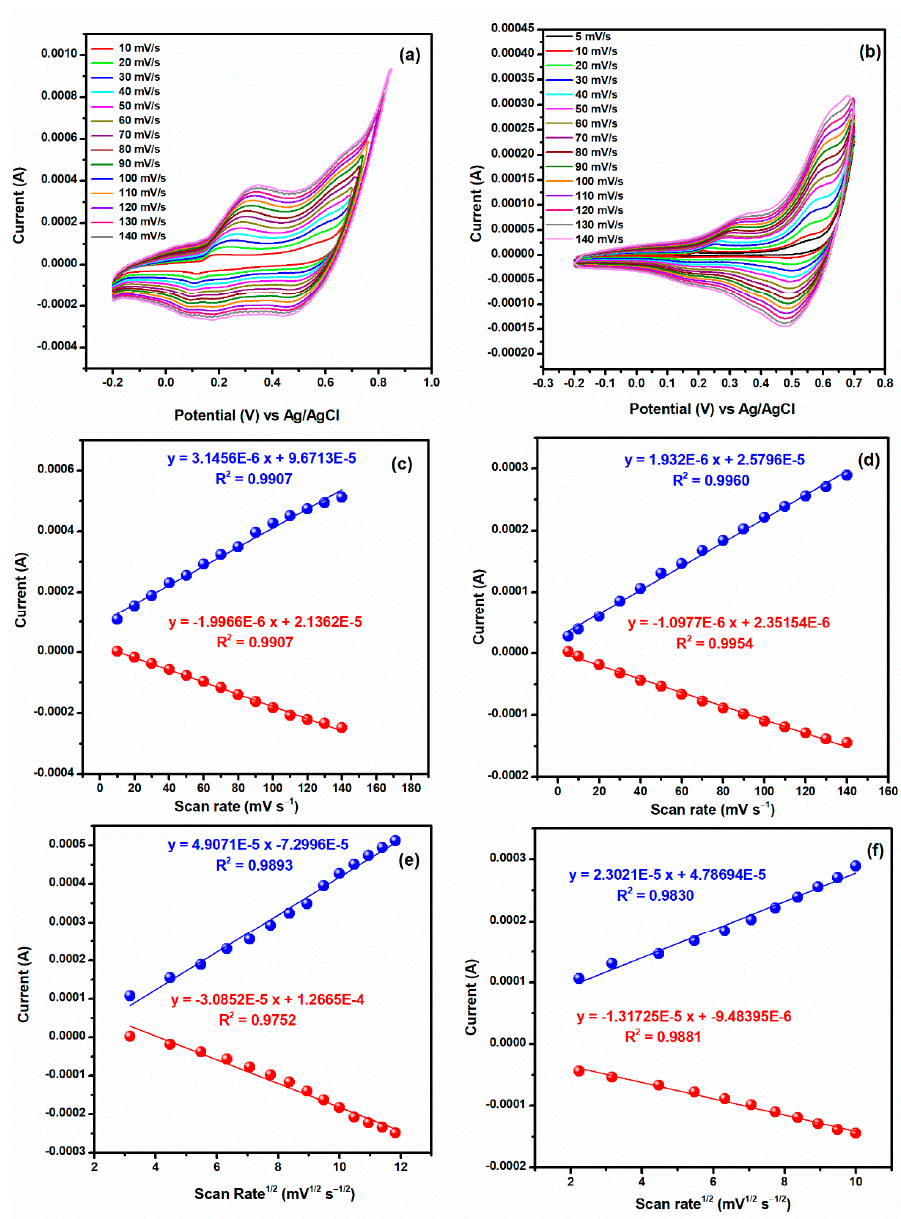
Figure 11. Cyclic voltammograms for the oxidation of 1.09 mM fructose at ( a ) HPC-Co (1) electrode and ( b ) HPC-CoO (2) electrode in 0.1 M NaOH at different scan rates (mV s − 1 ), ( c , d ) plot of current intensity for redox peak (III/IV) vs the scan rate ( e , f ) plot of current intensity for redox peak (III/IV) vs the square root of the scan rate of HPC-Co (1) and HPC-CoO (2) electrodes, respectively. To verify the possibility to develop fructose sensor, the electrochemical impedance spectra (EIS) was measured for both modified electrodes with a wide range of fructose concentrations (Figure 12a,b,d,e). The plots are well fitted with the equivalent circuit rep- resented in Figure 12d. The equivalent circuit consists of solution resistance (Rs), which reflects the ohmic resistance and the charge-transfer resistance (Rct) and Warburg element (W) connected in parallel with a constant phase element (CPE). The change of fructose con- centration is well reflected through Rs/Rso as it is directly proportional to fructose concen- tration up to 31 mM with a sensitivity of 0.048 mM − 1 for HPC-Co and up to concentration of 87.59 mM with a sensitivity of 0.0150 mM − 1 for HPC-CoO (Figure 12c). Alternatively, Bode plots showed that the complex impedance increases systemically (at a frequency of 1 Hz for HPC-Co and 100 kHz for HPC-CoO) with the increased in fructose